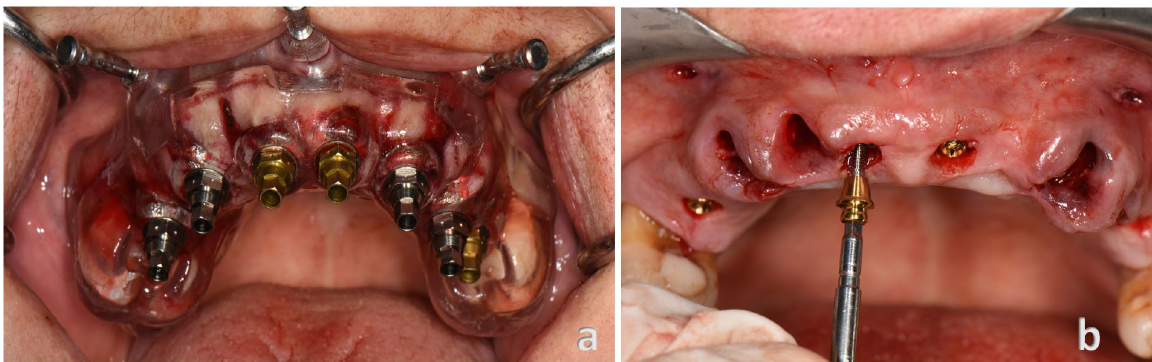
Figure 11. Implant insertion ( a ) and OT-Equator attachments positioning ( b ).